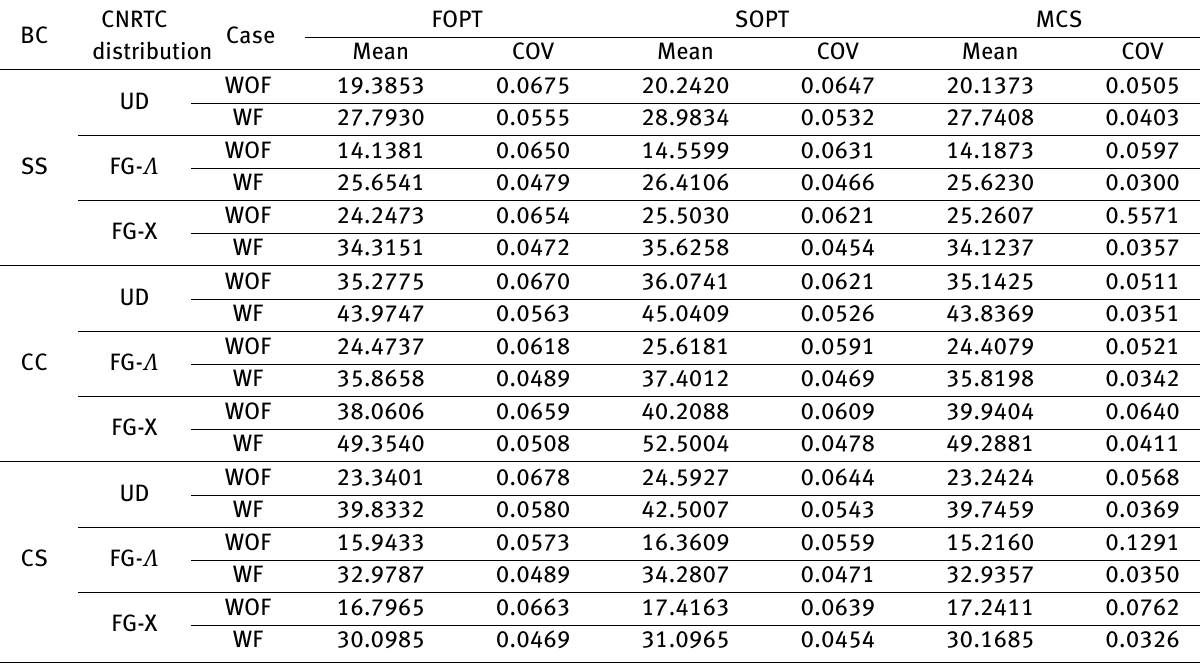
Table 8: Effects of boundary condition, UD , FG-X and FG- Λ considering with or without elastic foundation for random system properties { b i , ( i = 1 to 16) = 0.10 } on the dimensionless mean and COV of nonlinear fundamental frequency of CNTRC beam under with T = 300 K